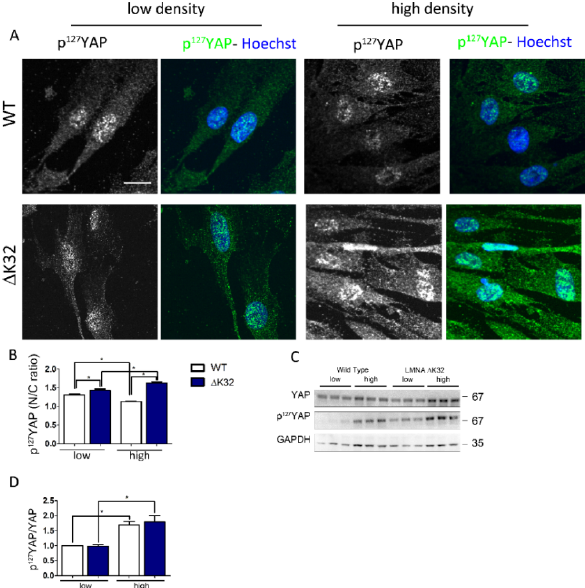
Figure 2. p S127 -YAP accumulates in the nucleus of LMNA Δ K32 MuSCs. ( A ) Confocal images of p S127 -YAP (green), in WT and LMNA Δ K32 mutant MuSCs cultured at low and high density conditions. Nuclei are stained with Hoechst (blue). Scale bar: 20 µm. ( B ) Quantification of p S127 -YAP nucleo-cytoplasmic (N/C) ratio. Values are expressed as mean ± SEM, n = 150 cells for each cell line. * p < 0.005 compared with WT. ( C ) Representative Western-blot of YAP, p S127 -YAP, and GAPDH in WT and LMNA ∆ K32 MuSCs plated at low and high cell density. ( D ) Quantification of p S127 -YAP / YAP protein levels in low and high density conditions, expressed in arbitrary units (a.u.). GAPDH was used as a loading control. Pooled values of WT (WT1 and WT2) are presented. Values are mean ± SEM, n ≥ 4 per conditions. * p < 0.005 compared with